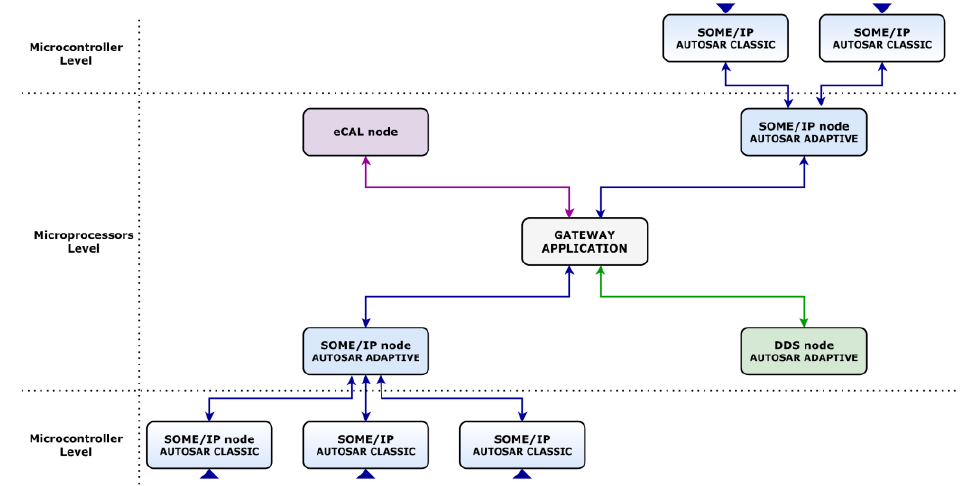
Figure 1. First industrial applicability perspective for the multi-protocol gateway.